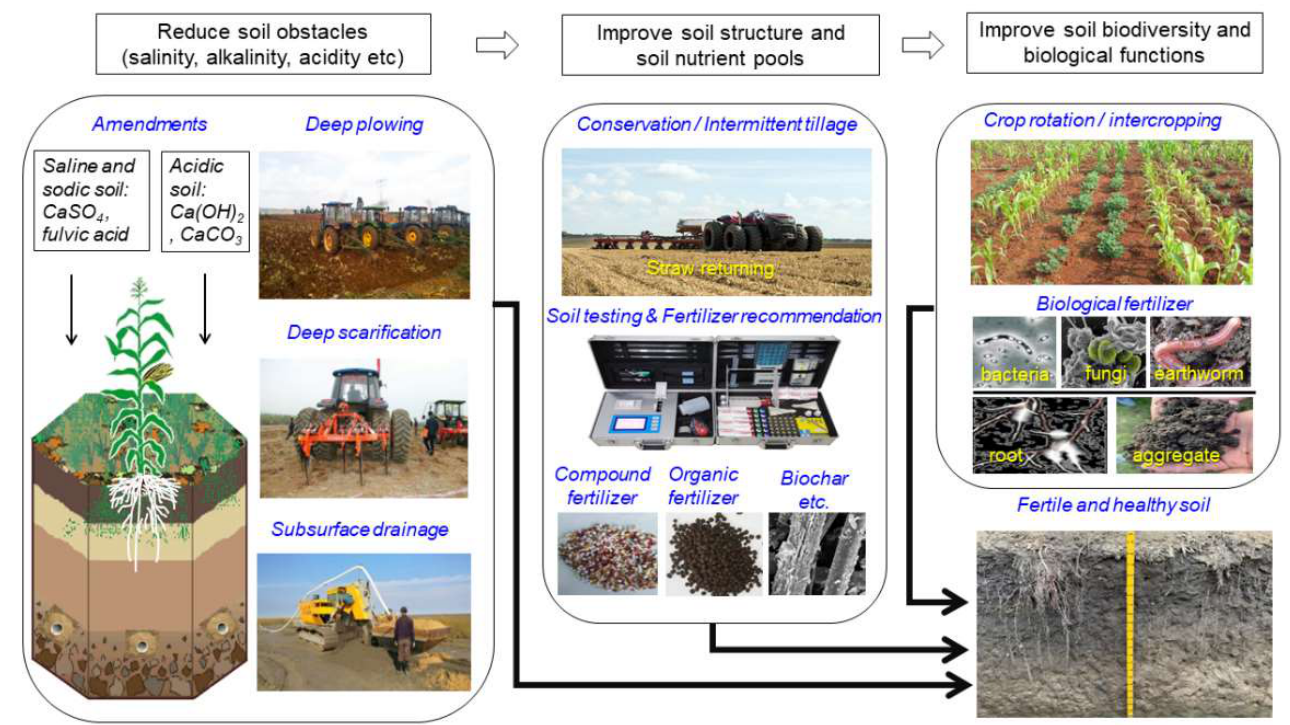
Figure 2. The construction pathway of fertile and healthy soil.